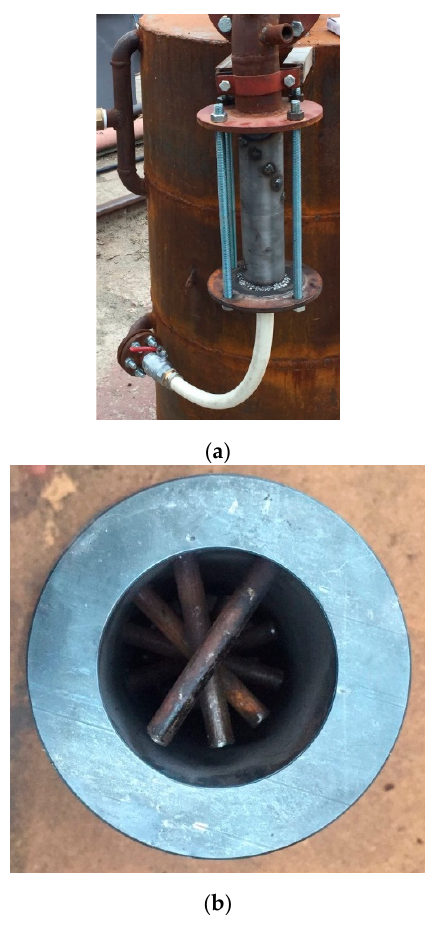
Figure 4. Heat exchanger for heating the air pressurized into the receiving chamber of the thermopressor: ( a ) installation of the heat exchanger on the thermopressor module; ( b ) location of internal ribbing. The data collection of the experimental unit parameters was carried out with a measure- ment interval τ = 1 s, and each parameter was covered by no less than 15 measurements.